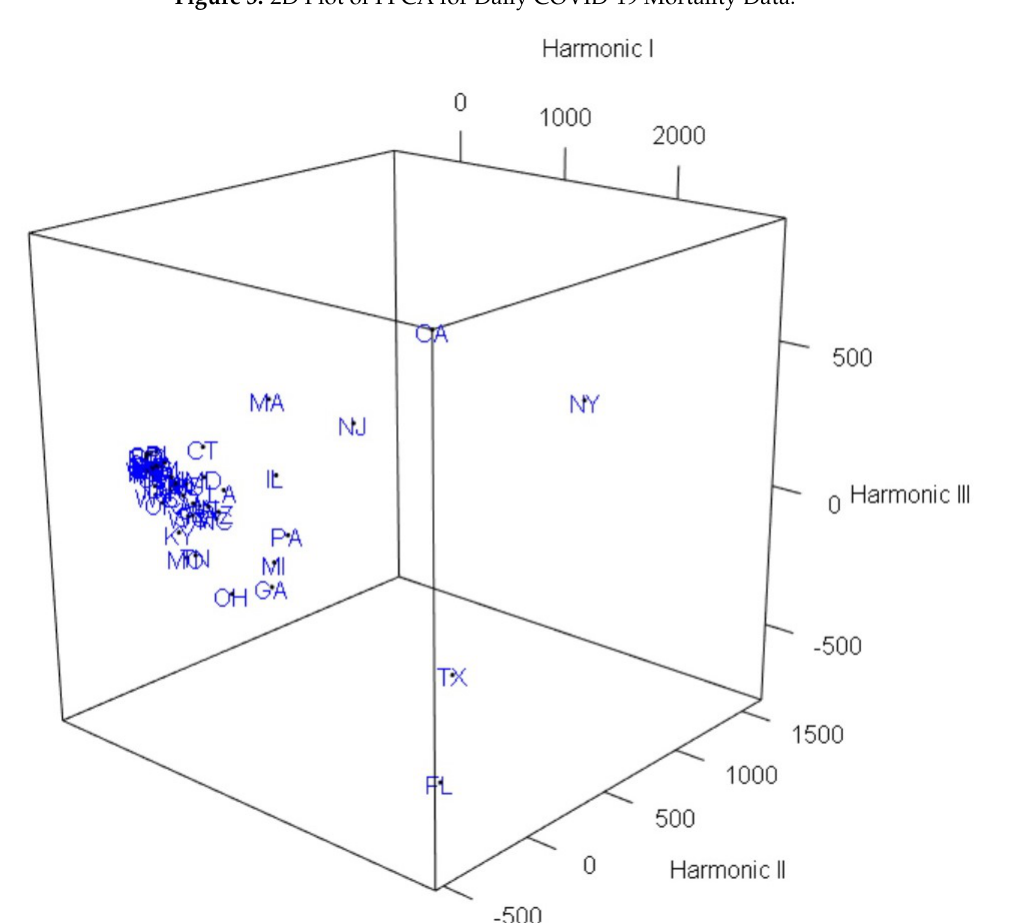
Figure 4. 3D Plot of FPCA for Daily COVID-19 Mortality